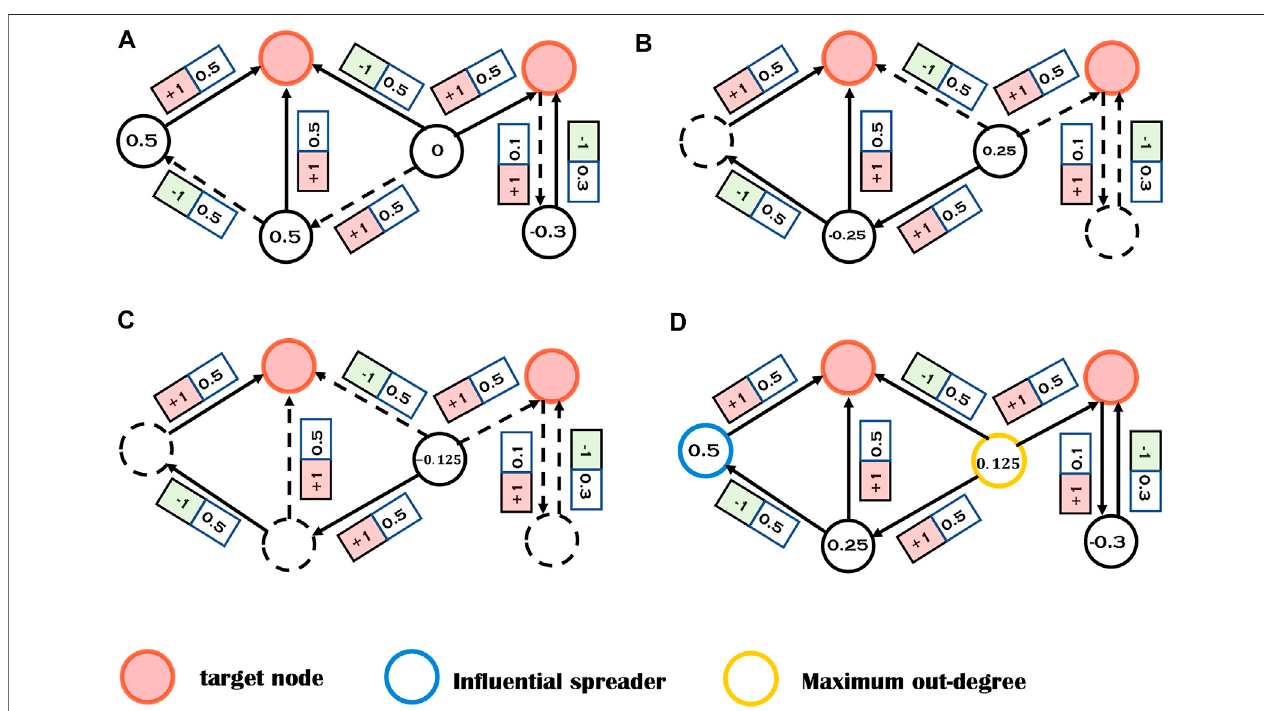
FIGURE 4 | Illustrations of the local in fl uence matrix (LIM) algorithm ( α (cid:1) 1, β (cid:1) 1, γ (cid:1) 0). The red nodes are target nodes and others are non-target nodes. (A) The nodes with numbers are directly connected with target nodes. All irrelevant nodes and edges are marked in dashed lines. The numbers on the nodes can be calculated by A · f . (B) The nodes with numbers can reach target nodes in exactly two steps. All possible paths with length two are considered and the numbers on nodes can be calculatedby (cid:1) A 2 · f . (C) Thenodeswithnumberscanreachtargetnodesinexactlythreesteps.Allpossiblepathswithlengththreeareconsideredandthenumbers on nodes can be calculated by (cid:1) A 3 · f . (D) The numbers on the nodes represent the LIM score when α (cid:1) 1, β (cid:1) 1, and γ (cid:1) 0. The blue and orange nodes have maximum LIM, out-degree values